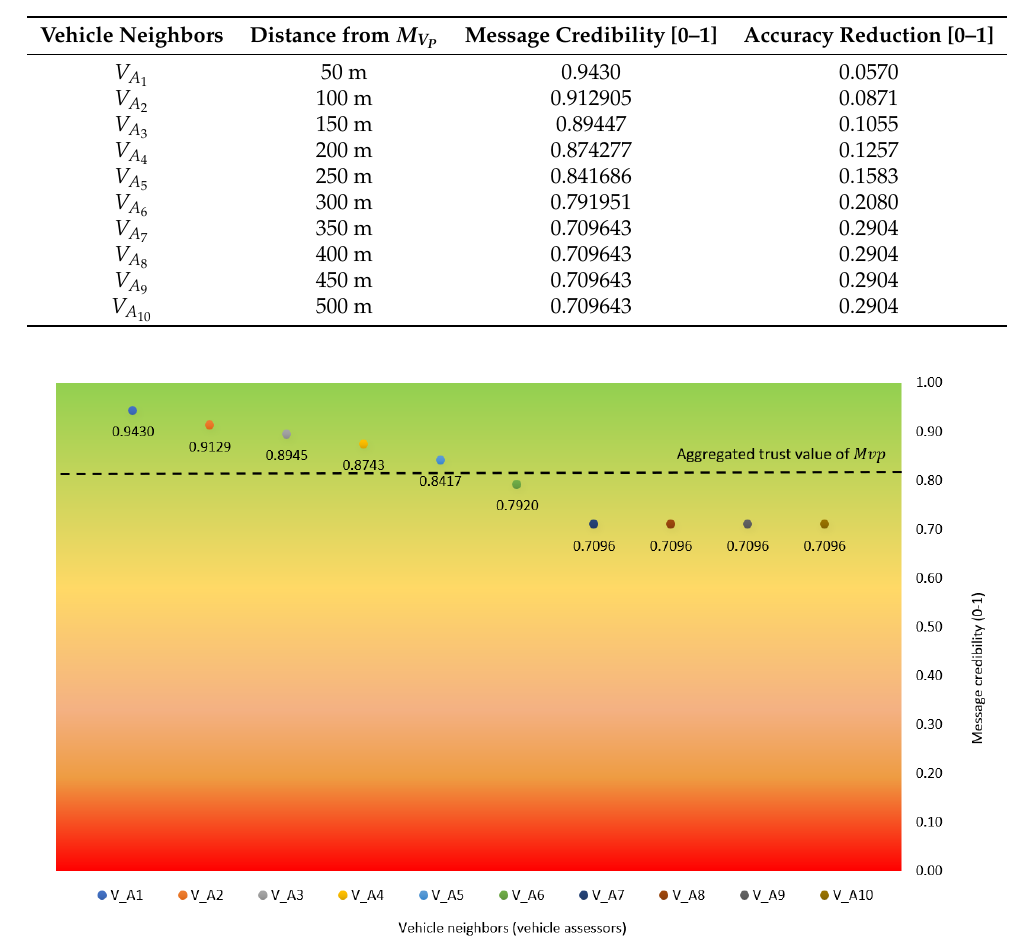
Table 3. Result of message credibility assessment of M V